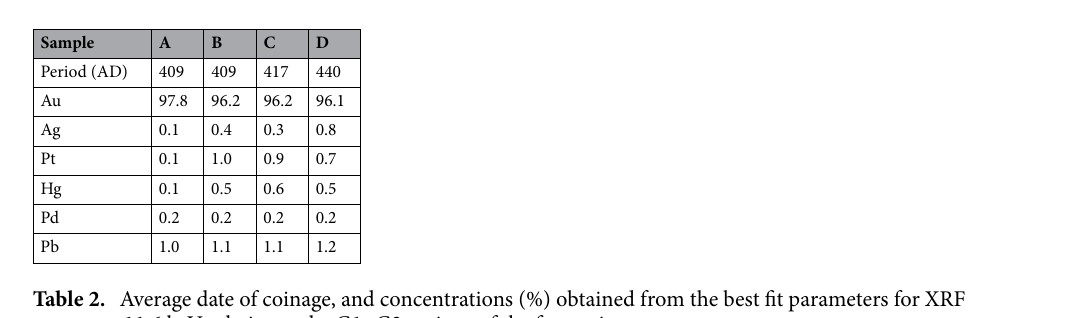
Table 2. Average date of coinage, and concentrations (%) obtained from the best fit parameters for XRF spectra at 11.6 keV relative to the G1+G2 regions of the four coins.